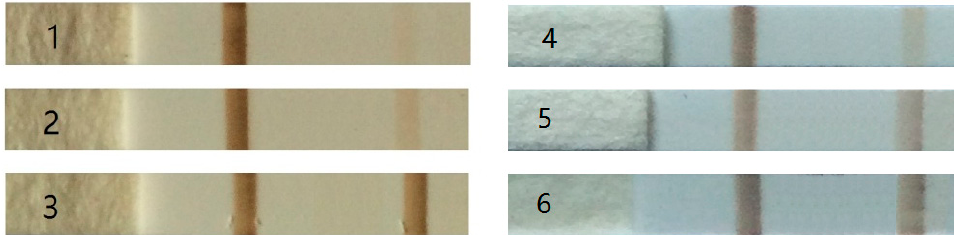
Figure 7. Standard lateral flow strips for sensitivity and limit test with different hCG concentration.